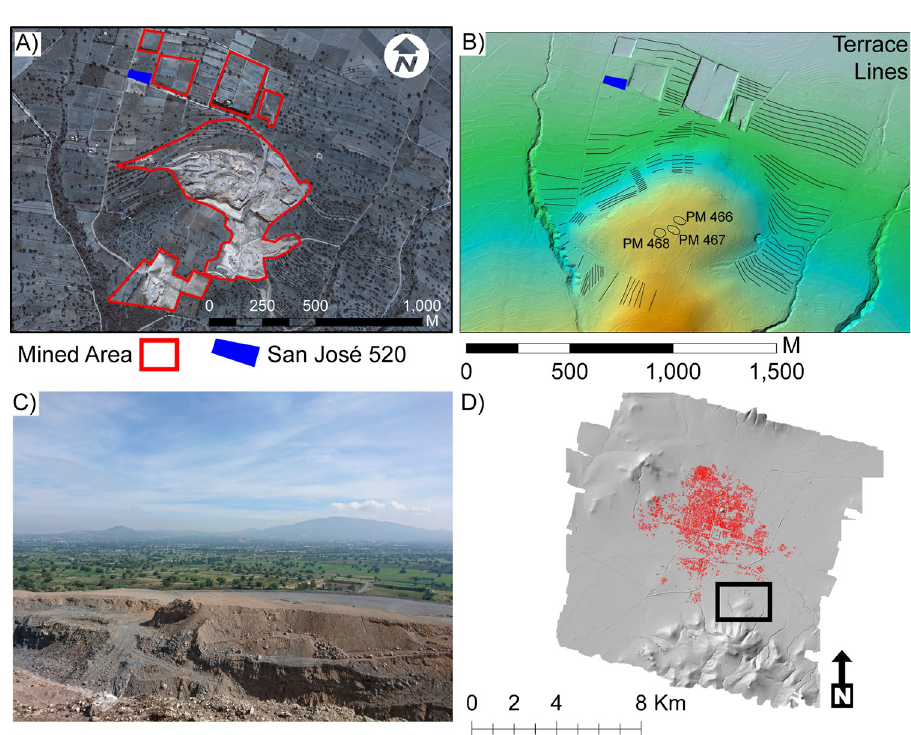
Fig 2. Mining example from Coatla´n, Sierra Patlachique’s northern slope. A) satellite image of mine extent (Worldview-3, December 12, 2017 courtesy of Maxar Technologies), B) lidar color-ramped DEM draped over sky- view factor of the same area from 2015 indicating terrace lines and three potential mounds, C) photograph of the mine taken from ground verifiction (looking southward) (Photograph: A. Texis), D) location of the mine within the Teotihuacan Valley indicated by the rectangle. PM = potential